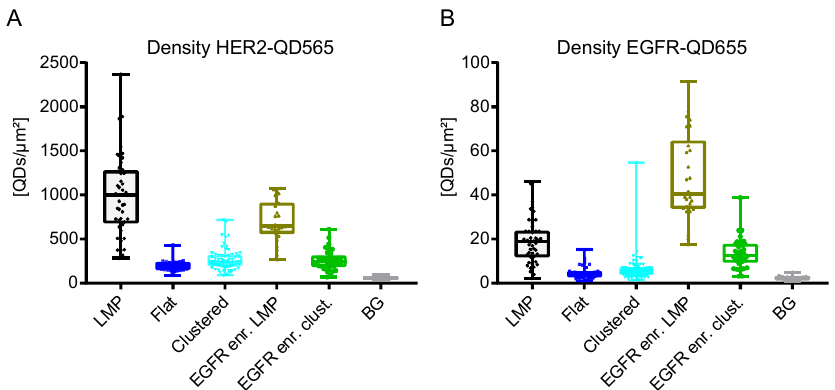
Figure 5. QD density and distribution analyses for SKBR3 cells dually labeled for HER2 and EGFR. ( A ) HER2-QD565 density and ( B ) EGFR-QD655 density for the different cell subtypes for SKBR3. Box-and-whisker plots indicate the mean labeled receptor densities, the lower and the upper quartiles, and the observed min to max values. Each dot represents the labeled receptor density from one image (see also Table 1). BG Background regions without